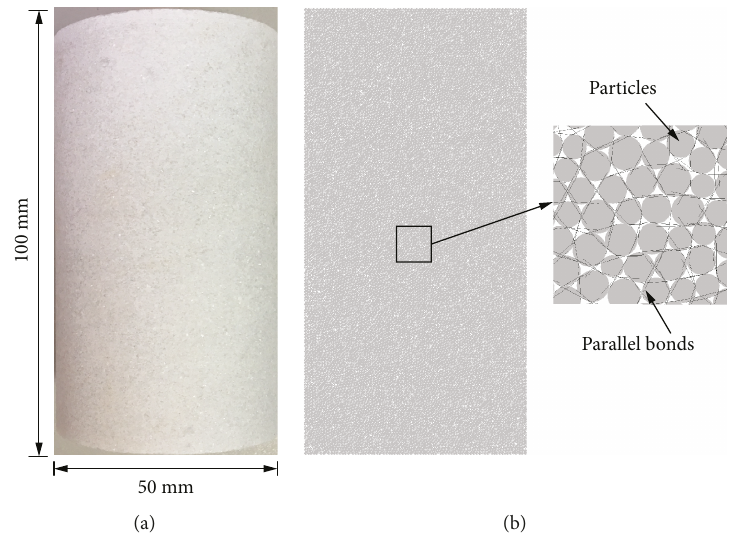
Figure 4: Intact marble specimens. Table 1: Microparameters of the numerical